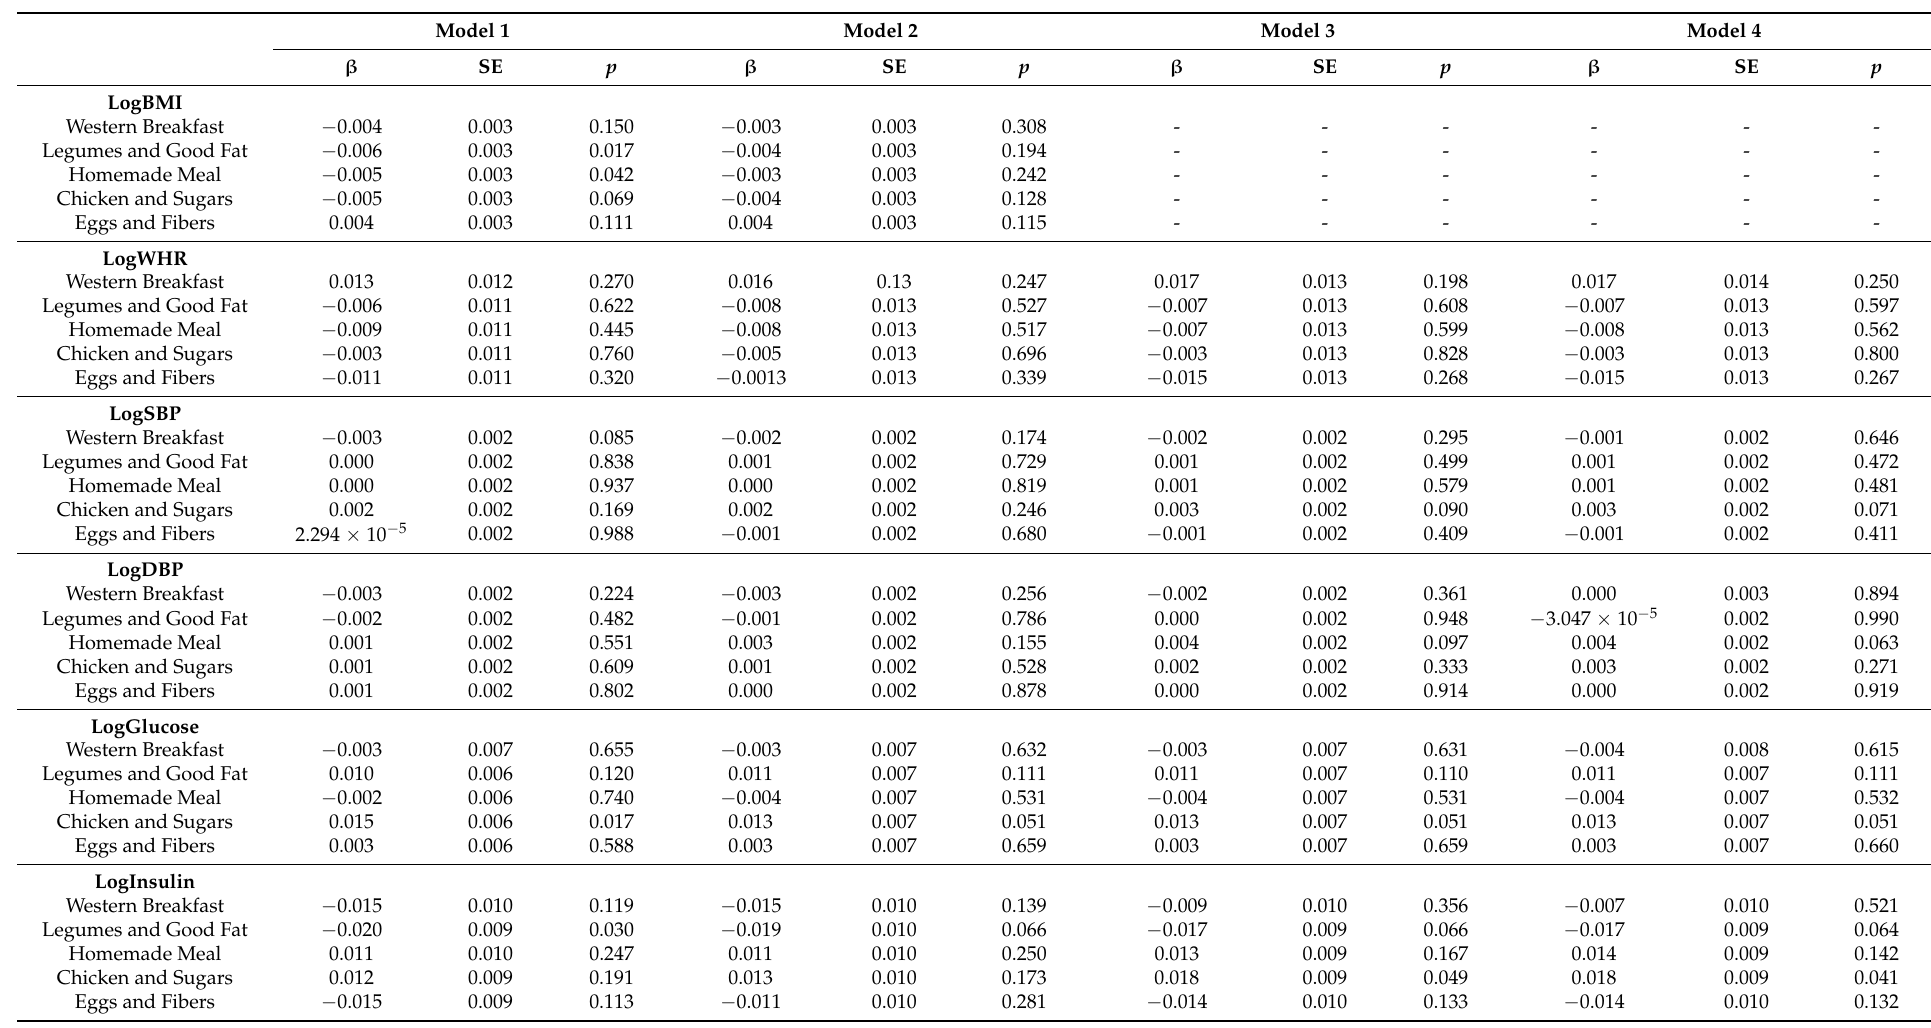
Table 5. Linear Regression Analyses on the association between the dietary patterns, anthropometric indices and biomarkers of glycemic and lipidemic control in the TEENAGE